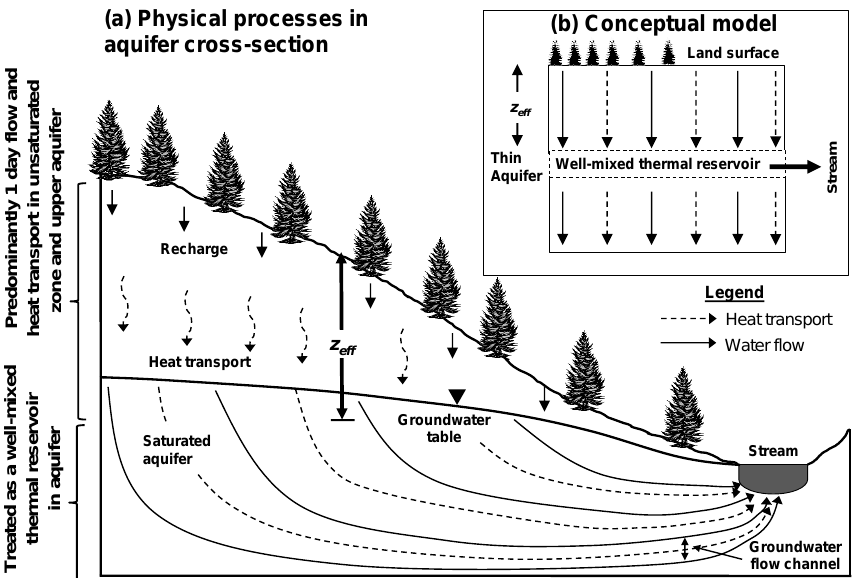
Figure 4. (a) Groundwater flow and heat transport in a two-dimensional cross section of an aquifer–stream system. (b) Conceptual model of the physical processes shown in (a) . Dashed arrows indicate heat transport, and solid arrows indicate water